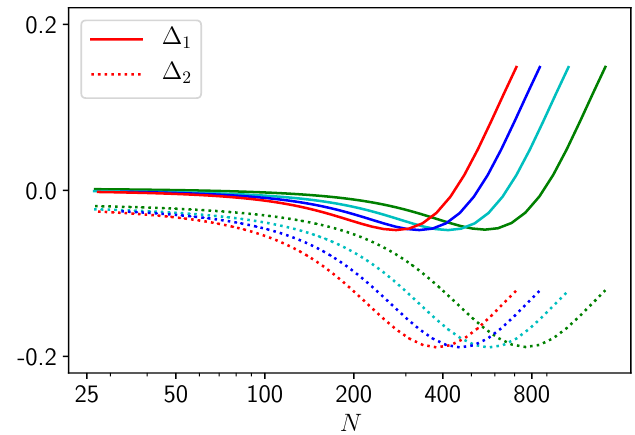
Figure 4: Errors ∆ between HF and YY + LDA from Eq. (53) for T = 60K. The colors 1,2 correspond to ω (cid:107) = 2 π · 7.5Hz (green), ω (cid:107) = 2 π · 10Hz (cyan), ω (cid:107) = 2 π · 12.5Hz (blue) and ω (cid:107) = 2 π · 15Hz